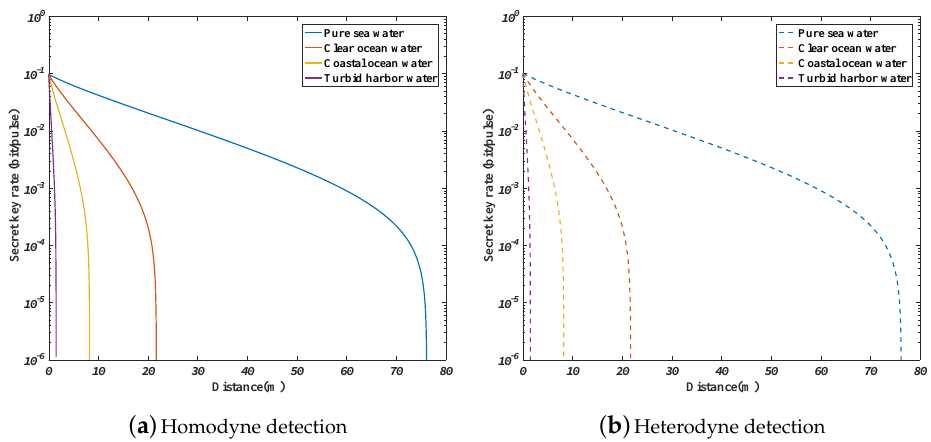
Figure 5. (Color online.) Secret key rate of the four-state protocol for realistic reconciliation efficiency of 90% and a quantum efficiency of Bob’s detection equal to 0.6 with thermal noise v el = 0.01. V A = 0.6, ε = 0.01 (in shot-noise unit).